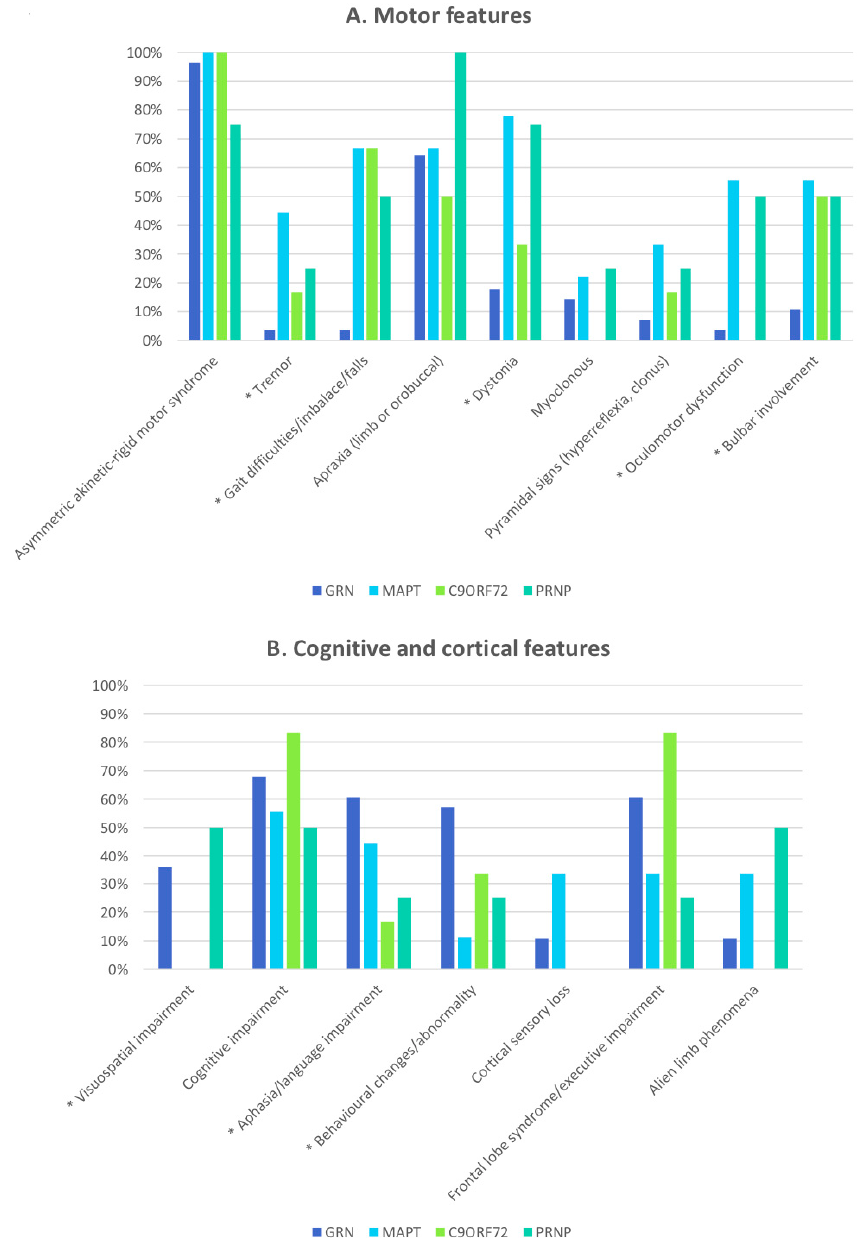
Figure 1. Histograms showing the frequency of motor ( A ) and cognitive ( B ) features in patients with CBS associated with mutations in GRN , MAPT , C9ORF72 , and PRNP . The asterisk (*) marks clinical features that were statistically different between GRN patients and non- GRN cases, as reported in Table